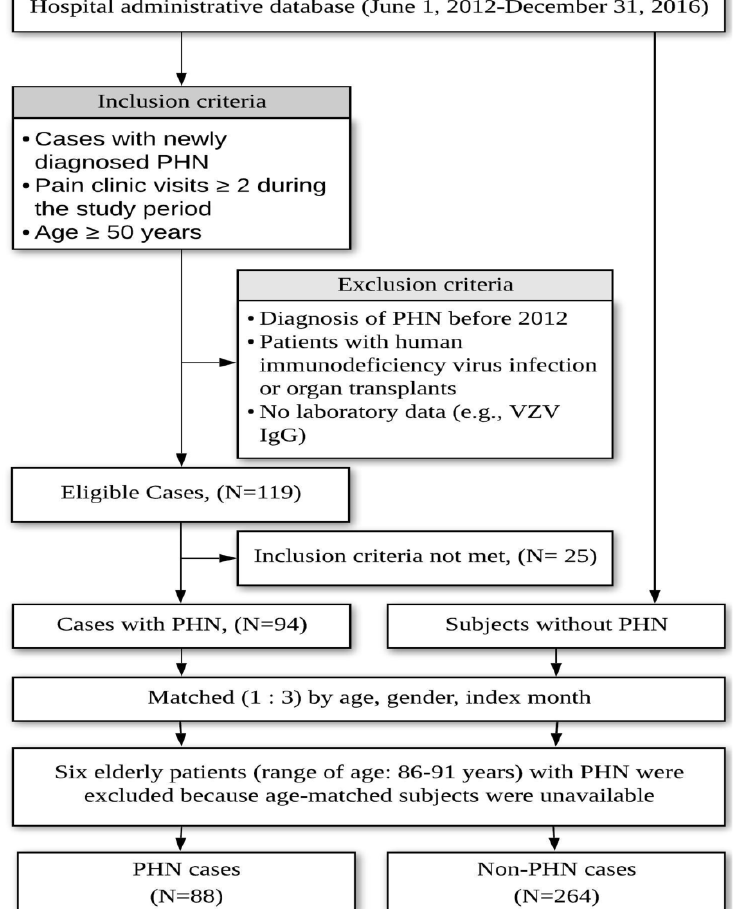
Figure 1. Flowchart of participant recruitment and case–control selection in Part I study.